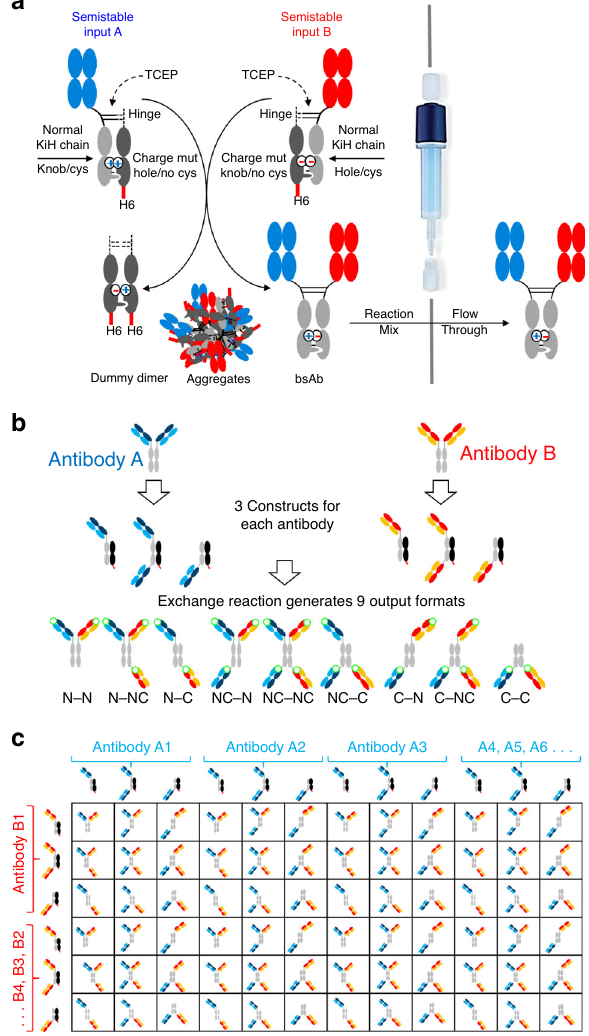
Fig. 1 Generation of combinatorial binder/format bsAb matrices via dummy-Fc driven assembly. a Af fi nity tag-containing dummy chains drive bsAb assembly and enable one-step puri fi cation. b Combination of educts of different formats generates bsAb format diversity. Green circles indicate the location of paratopes in output formats. c Combining binders in different input formats multiplies the binder – format design space. Each product within the matrix is a unique bsAb with a speci fi c binder combination in a speci fi c